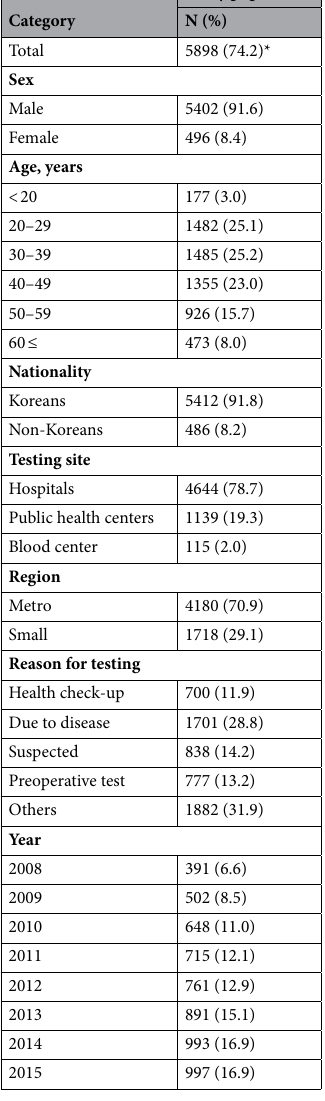
Table 1. The characteristics of study population for the recent HIV infection study in Korea from 2008 to 2015. *Proportion of specimens for recent HIV testing among 7945 newly HIV diagnosed individuals in Korea from 2008 to 2015. Metro metropolis, small smaller city or rural area, others prenatal check-up, blood donation, partner of HIV positive, sexual transmitted infection risk group, etc. Age median of specimens for study: 38